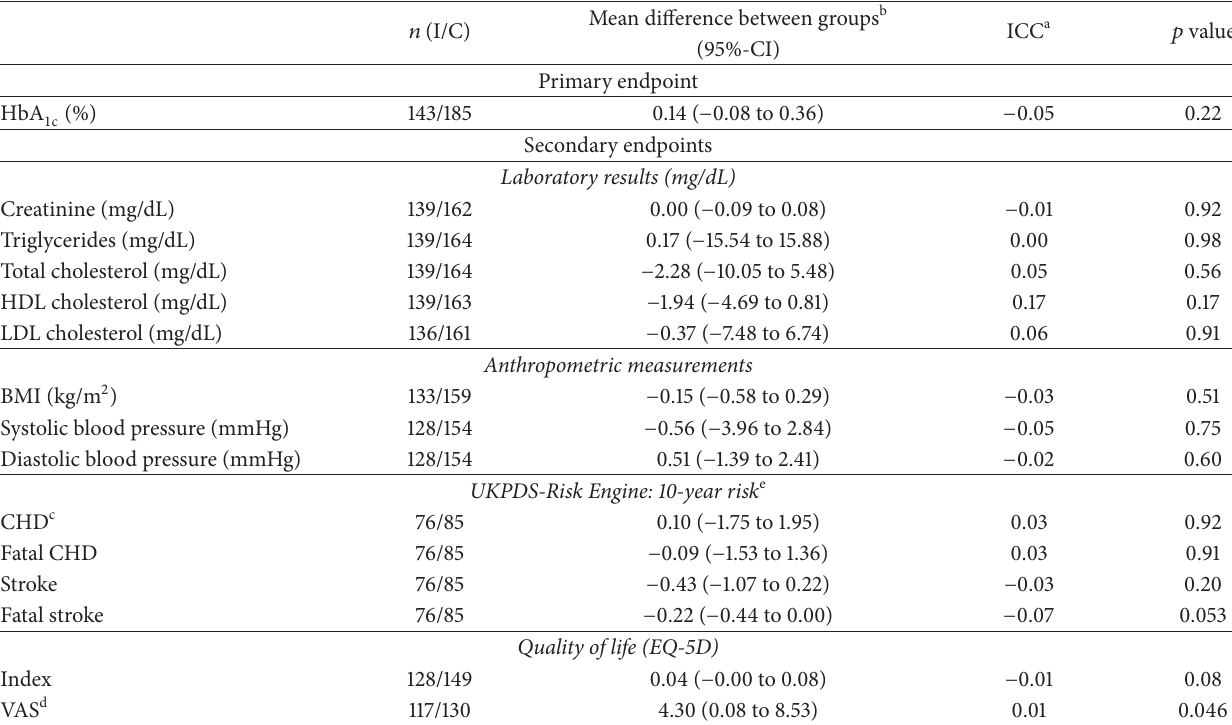
Table 4: Differences between groups regarding primary and secondary outcome measures, adjusted for baseline values, age, and ICC.